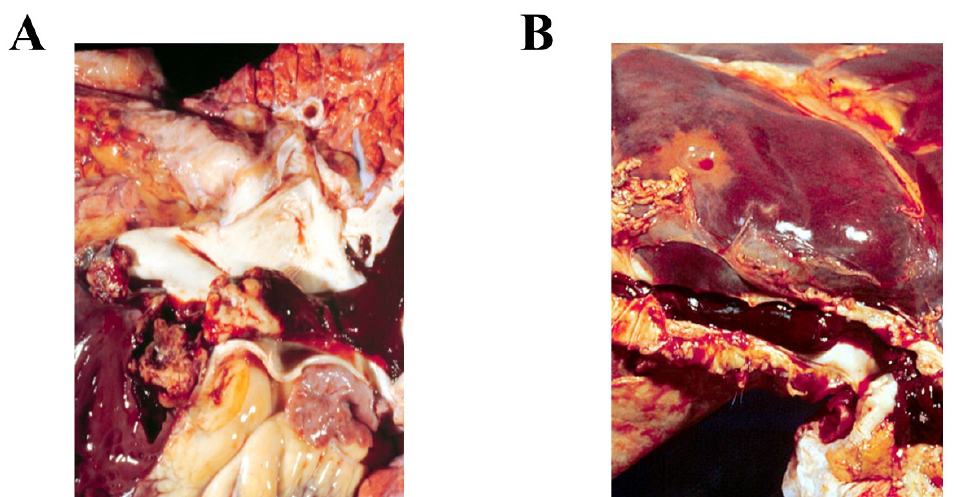
Figure 4. Macroscopic appearance of a ( A ) white thrombus in a patient with carotid artery occlusion and of a ( B ) red thrombus in a patient with deep vein thrombosis.